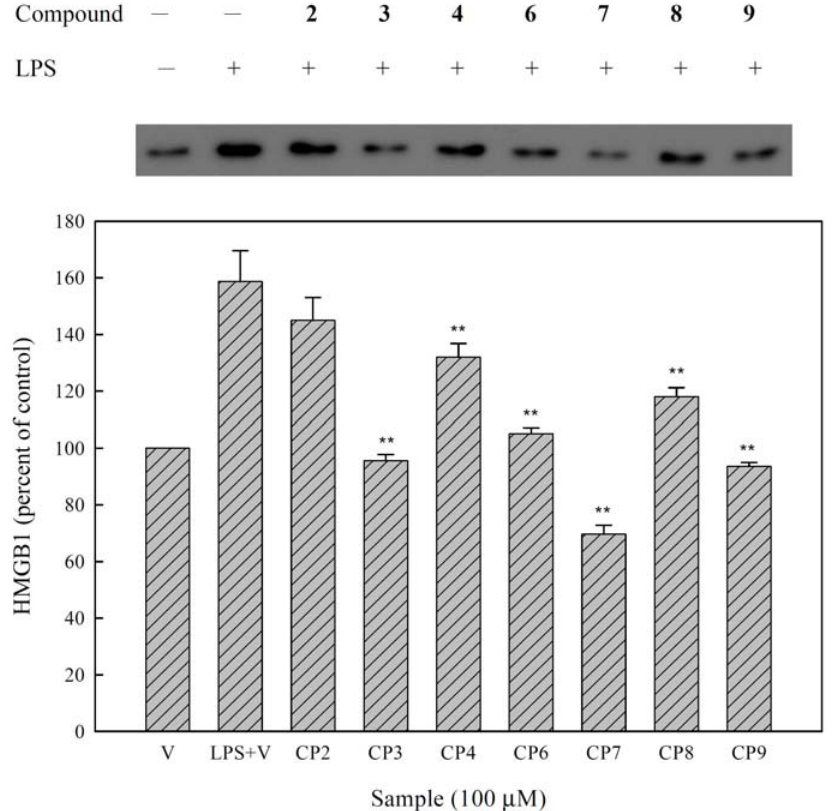
Figure 2. Effects of the constituents of leaves from M. zuihoensis on LPS-induced HMGB-1 protein secretion in RAW264.7 cells. Cells were treated with compounds 2 – 4 , 6 – 9 (100 μ M) for 2 hours followed by the addition of LPS (20 ng/mL − 1 ). Levels of HMGB-1 in the culture medium were determined by Western blot analysis at 30 hours after LPS stimulation. The statistical analyses for LPS + V and compounds treatment were performed using student’s t test. Significant inhibition is indicated by **, with a P -value <